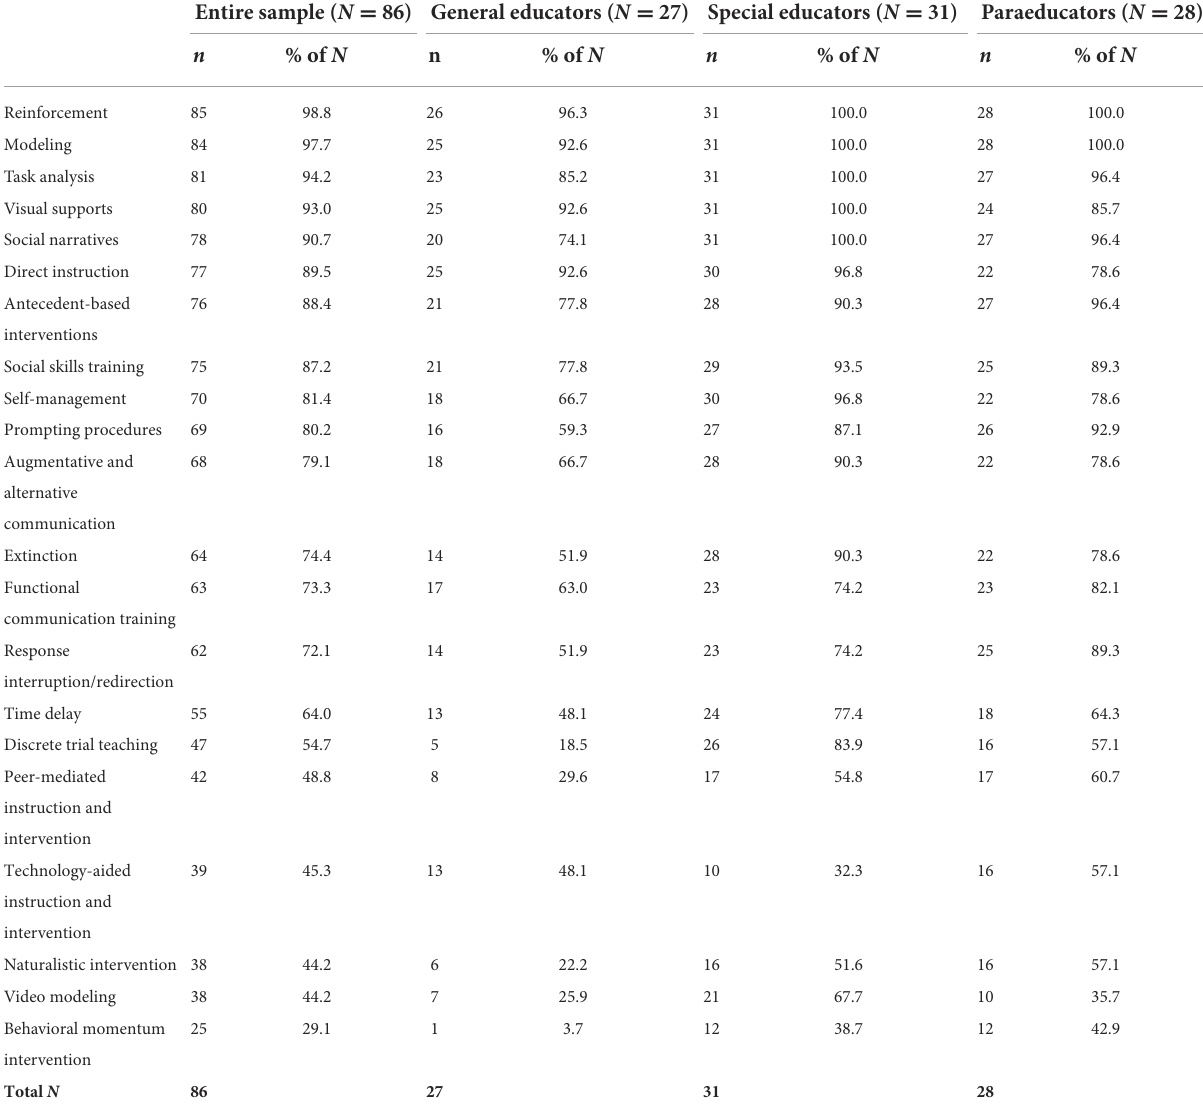
TABLE 2 Multicomponent practice and strategies heard of (ranked by entire sample). Heard of multicomponent practices and